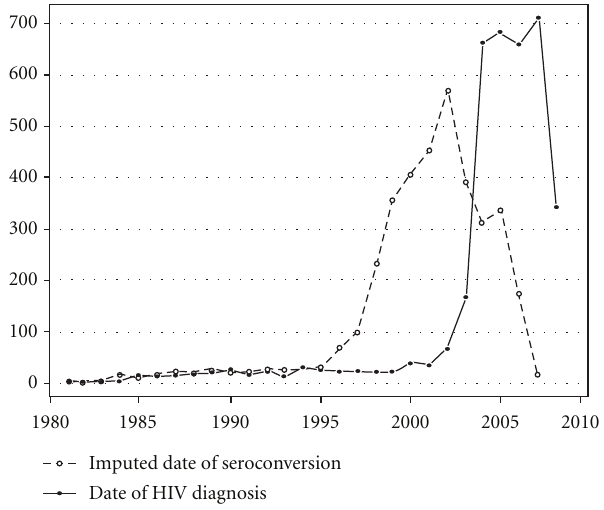
Figure 1: Distribution of date of seroconversion and date of HIV